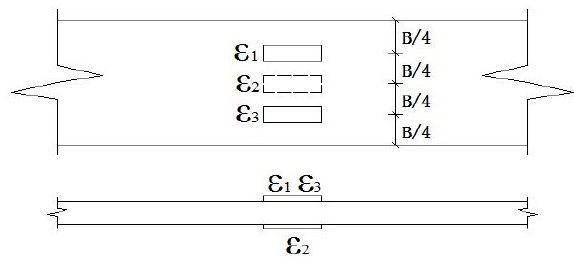
Figure 3. Strain gauge distributions of the BFRP sheet.